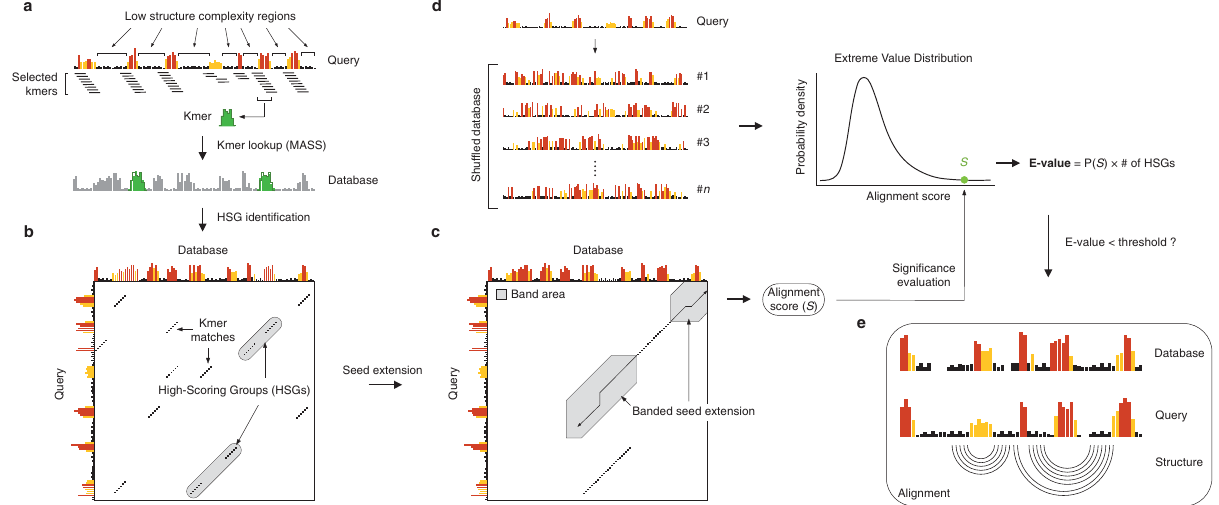
Fig. 1 Schematic of the SHAPEwarp algorithm. a All the possible kmers along a query SHAPE reactivity pro fi le are enumerated, discarding those having low structure complexity. Retained kmers are looked up into the database via the MASS algorithm. b A matrix is built storing the coordinates of each query kmer and its matches in the database, allowing the grouping of kmers lying on the same diagonal into high scoring groups (HSGs). c Each HSG is used as the seed to begin the bidirectional extension of an alignment. Banding of the alignment restricts the search space to a maximum number of bases around the diagonal. The alignment stops when the score ( S ) drops below a certain threshold for more than a certain number of bases. d In parallel, the same query is searched against a database of shuf fl ed SHAPE reactivity pro fi les. The scores of these alignments are used to build the null distribution, further allowing to estimate the probability of obtaining an alignment score ≥ S . From this the E-value of the alignment can be estimated. e Optionally, signi fi cant alignments can be further analyzed for the presence of a conserved structure by exploiting the RNAalifold